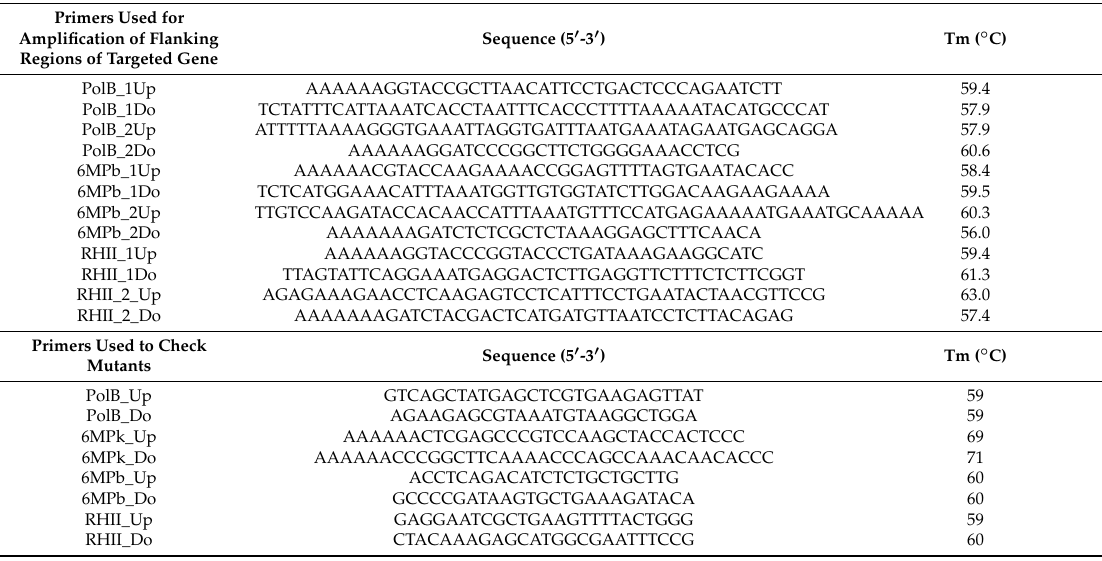
Table 2. List of primers used in this